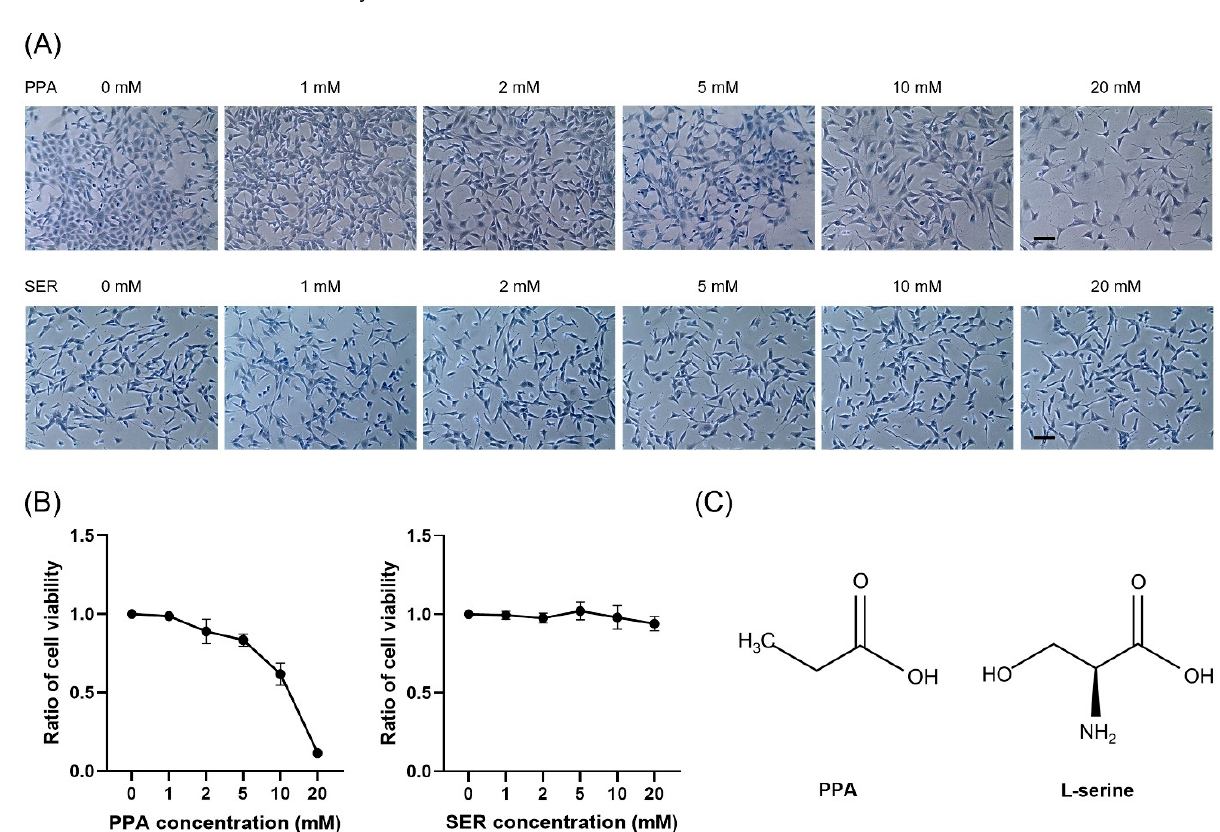
Figure 1. The effect of different concentrations of propionic acid (PPA) or L-serine (SER) on the viability of HT22 cells. ( A ) Representative images of HT22 cells stained with trypan blue. Scale bar, 100 µ m. ( B ) Six PPA concentrations from 0 to 20 mM in DMEM medium were set. HT22 cells were incubated in a medium with different PPA concentrations for 48 h. Cell viability was measured by CCK-8 assay ( n = 3 replicates). Cells were treated with equal amounts of L-serine (SER) or PPA in DMEM medium for 48 h. L-serine (SER) has no toxicity in HT22 cells. ( C ) Chemical structures of PPA and L-serine.